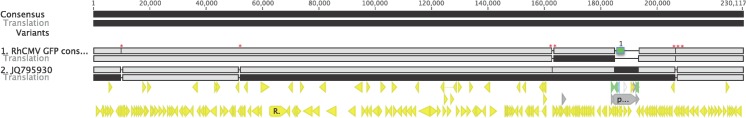
Sequence alignment comparing RhCMV-eGFP to RhCMV 68–1 BAC.Sequence of RhCMV-eGFP obtained from NGS analysis was aligned with that of RhCMV 68–1 BAC (JQ795930) using Geneious Pro 6.1.4 software. Whole genome comparisons yielded 96.2% similarity and the major difference can be attributed to the BAC cassette present in RhCMV68-1 BAC. “1” refers to eGFP reporter * sequencing error;** 22 bp deletion; *** 56 bp insertion.